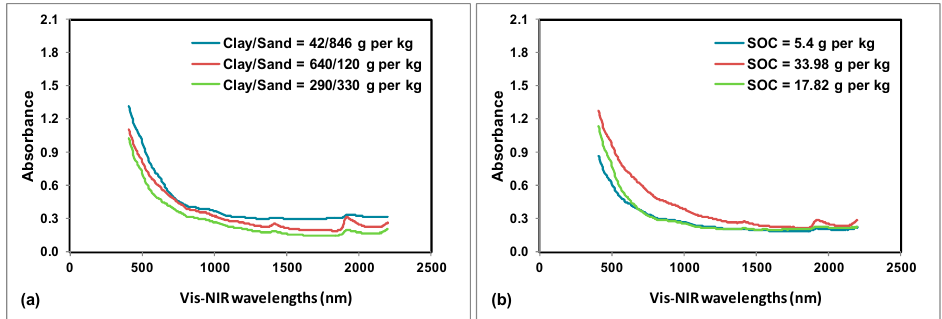
Figure 4. Example of portable vis-NIR soil absorbance measurements recorded on selected soil samples with varying sand and clay ( a ) and SOC content ( b ).